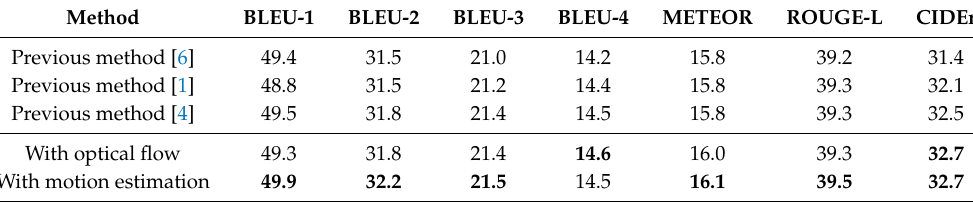
Table 2. Results of experiment 3 conducted with the MSR-VTT2016-Image dataset (average of five runs). With optical flow: Our proposed model, with optical flow for motion features. Optical flow was calculated using two consecutive images. With motion estimation: Our proposed model. For motion features, the estimated optical flow was used. The best value for each metric is shown using bold